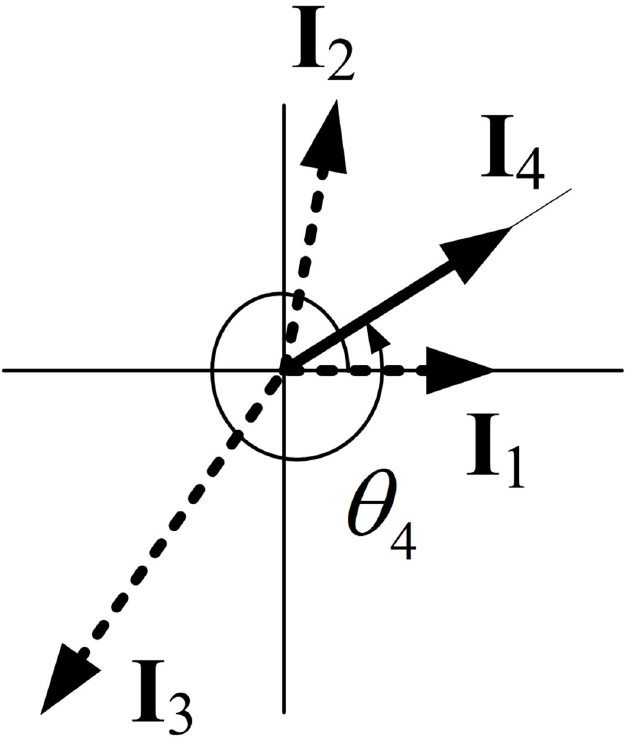
Fig 3. Impulse vector diagram of an SD shaper with a shaping time 1 < T s � 1.5. Because the shaping time T s is between 1 < T � 1.5, the SD shaper is composed of four s